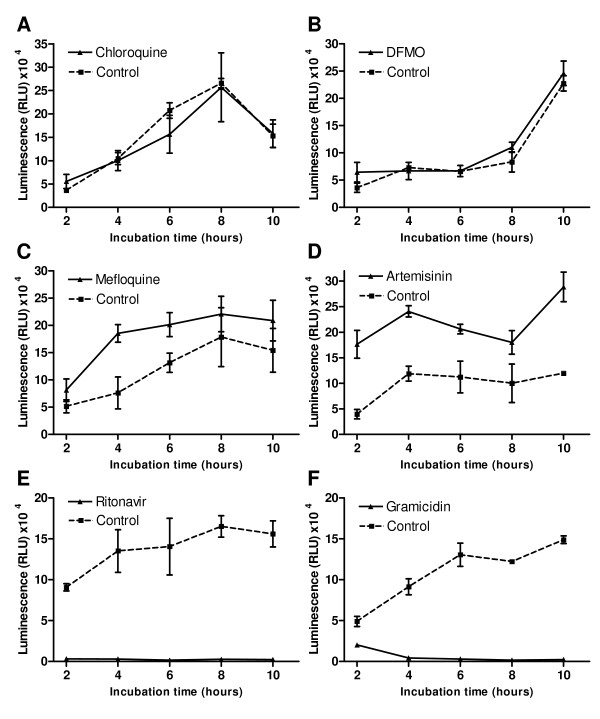
Variation in ATP levels in drug-treated parasites. Plasmodium falciparum 3D7 parasite cultures were incubated for 10 hours with 100 nM chloroquine (A), 10 mM DFMO (B), 100 nM mefloquine (C), 100 nM artemisinin (D), 100 μM ritonavir (E) or 0.1 nM gramicidin (F). At 2-hour intervals, aliquots were removed from drug exposed (solid line) and solvent control (dotted line) cultures, parasites were isolated by saponin lysis and centrifugation through a phthalate oil layer, and their ATP content determined with a luminescence based CellTitre-Glo® reagent (Promega). Individual data-points are mean luminescence values (relative light units – RLU) from three aliquots per culture processed in parallel and error bars indicate the standard deviation.